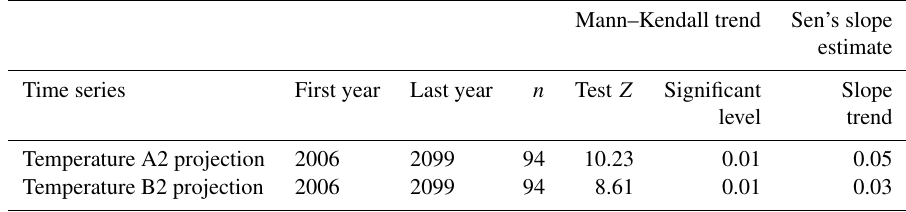
Table 1. The amount of Z test and trend slope of the temperature average at Tehran synoptic stations during 2006–2099.